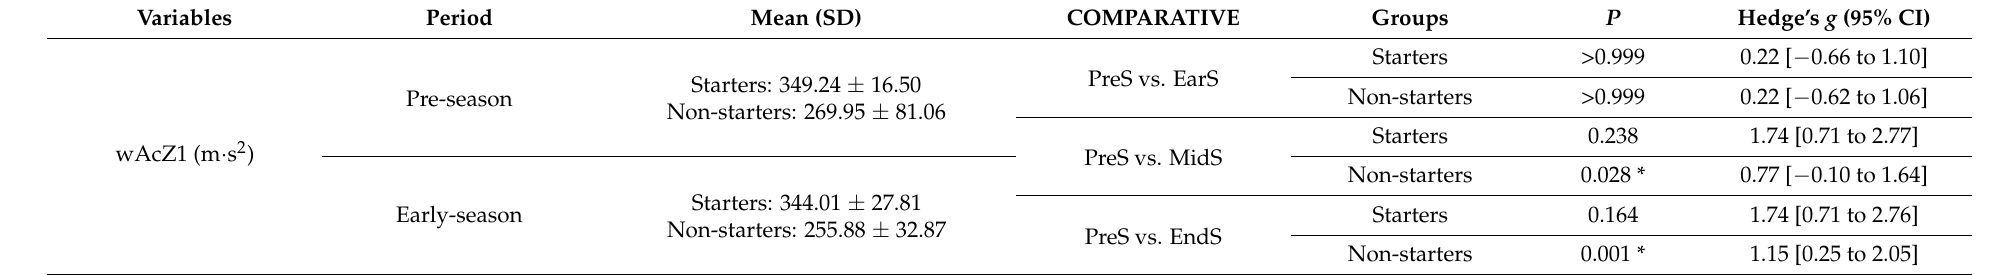
Table 3. Within-group differences for pairwise comparisons between season periods in wAcZ1 and wDcZ1 for both non- and starter